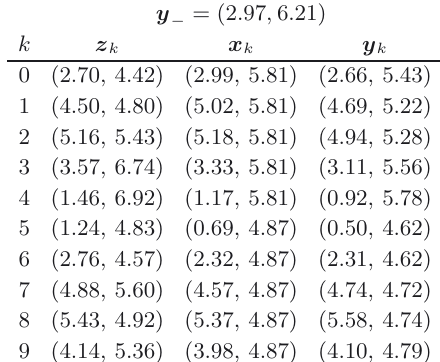
Table 1. Measured ( z ), theoretical ( x ), and estimated ( y ) vectors of Figure 3.